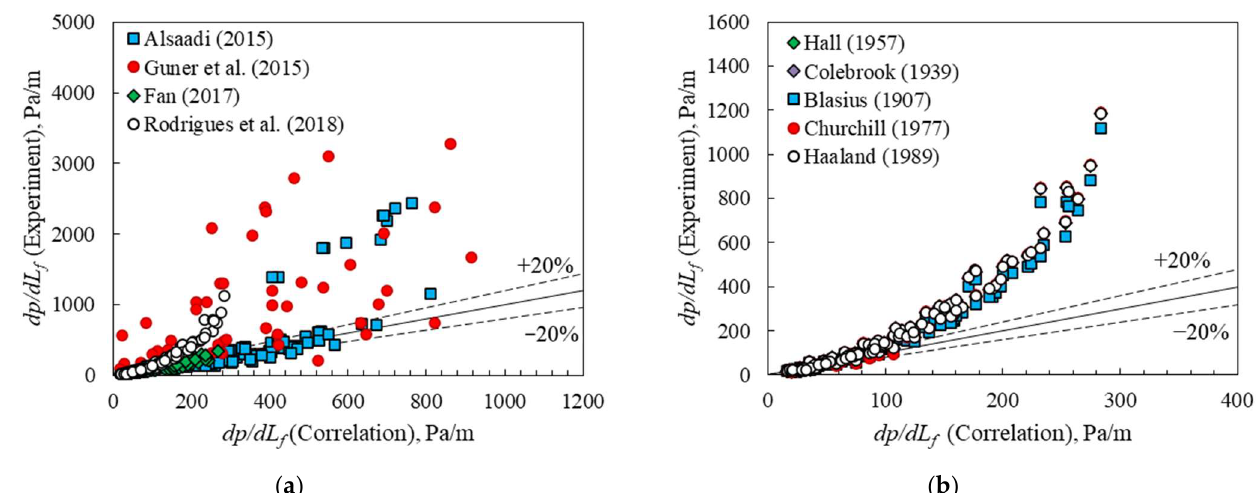
Figure 2. Comparison of experimentally measured frictional pressure gradient with calculated values from correlations for ( a ) different datasets with various flowing conditions and ( b ) various wall friction correlations.